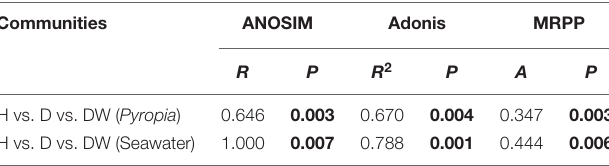
TABLE 2 | Significance tests of the differences in Pyropia yezoensis - and seawater-associated bacterial community structures, respectively on the basis of Bray-Curtis dissimilarities.